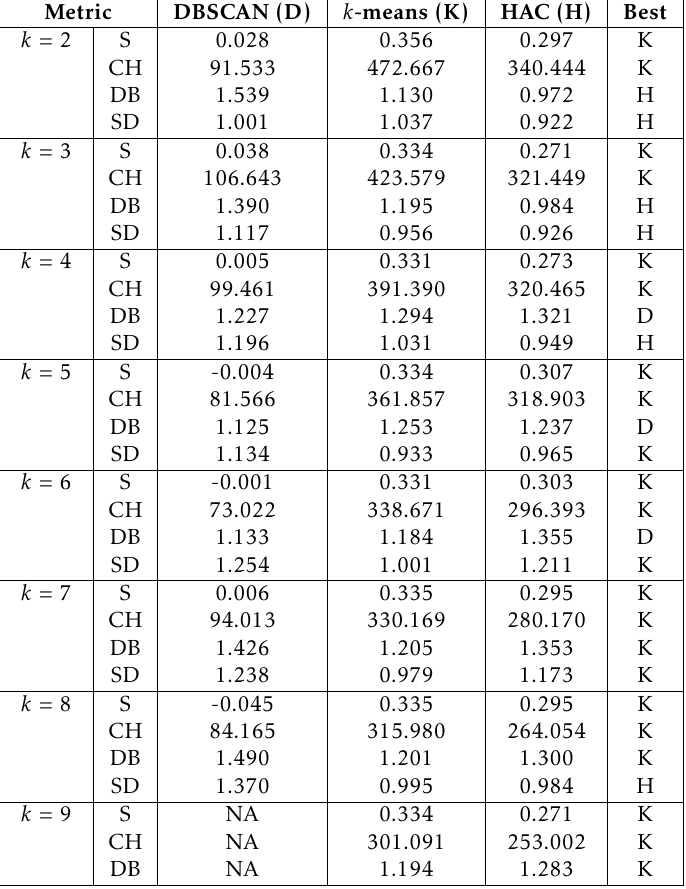
Table C.5. Performance of user clustering (Dataset NMI